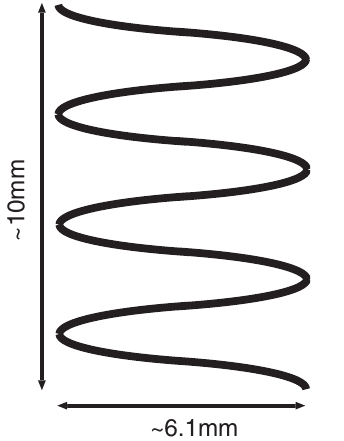
FIG. 1. A trace drawn by the aborted bunches on the beam dump in KEKB HER. This pattern is made from vertical and horizontal kicks.